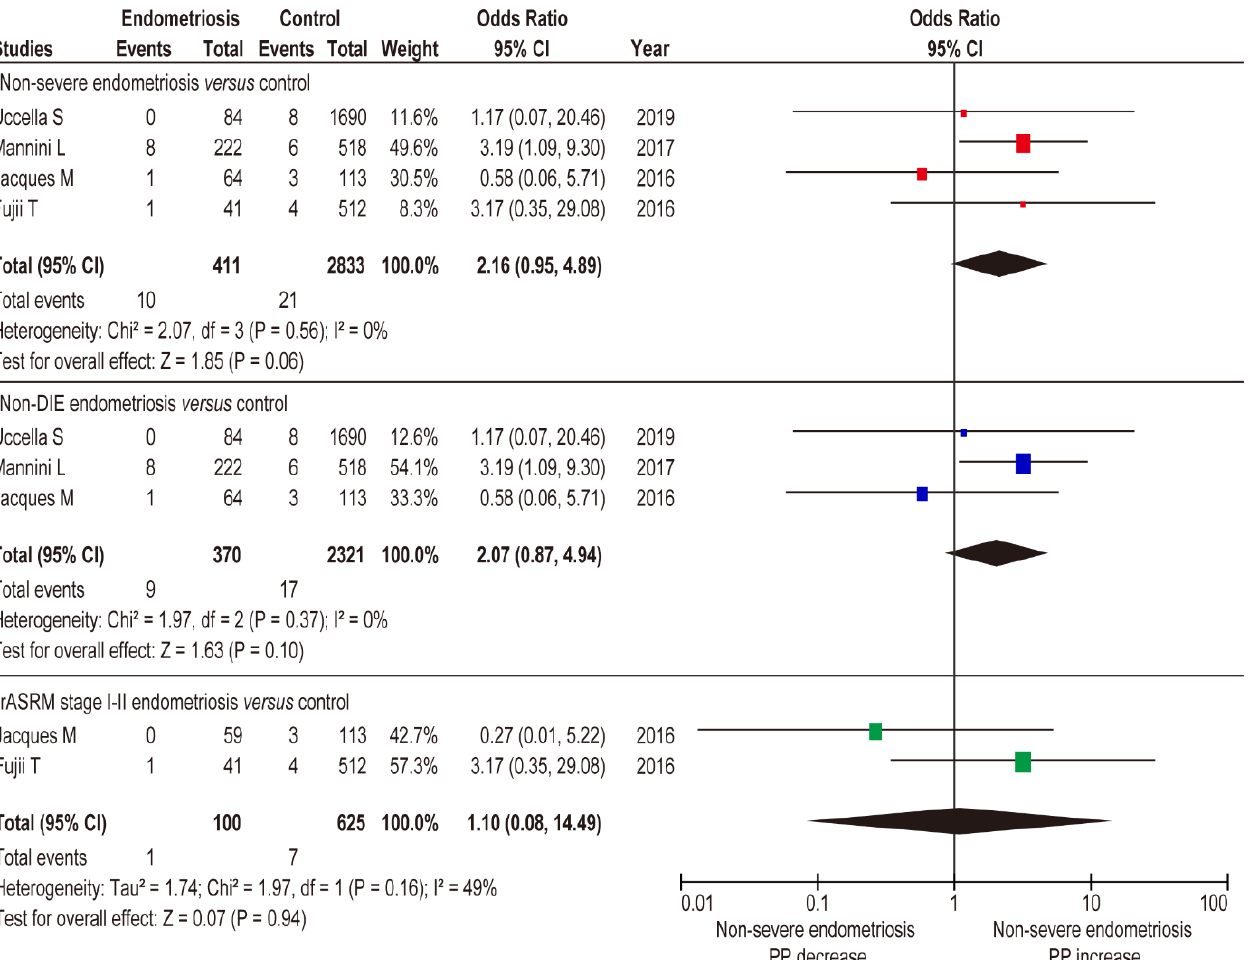
Figure 5. Influence of non-severe endometriosis on the occurrence of PP. Pooled odds ratio of unadjusted analyses for PP. The position of the box is a point estimate of the OR. The size of the box represents the weight of study. A horizontal line representing the 95%CI of the study result, with each end of the line representing the boundaries of the CI. The diamond represents the combined results of the studies. ( A ) non-severe endometriosis versus control, ( B ) non-DIE versus control, and ( C ) rASRM stage I–II endometriosis versus control. The forest plots were arranged within the stratum by year of publication and the relative weight (%) of the study. Low heterogeneity was observed in the analysis of panel C ( I 2 = 49%), whereas no heterogeneity was observed in the analysis of panels A and B ( I 2 = 0%). Therefore, a fixed-effects analysis was applied to panels A and B, whereas a random-effect analysis was used for panel C. Some values may slightly vary from the original values, as calculations were performed using Revman ver. 5.4.1. Abbreviations: OR, odds ratio; SE, standard error; CI, confidence interval; and PP, placenta previa.